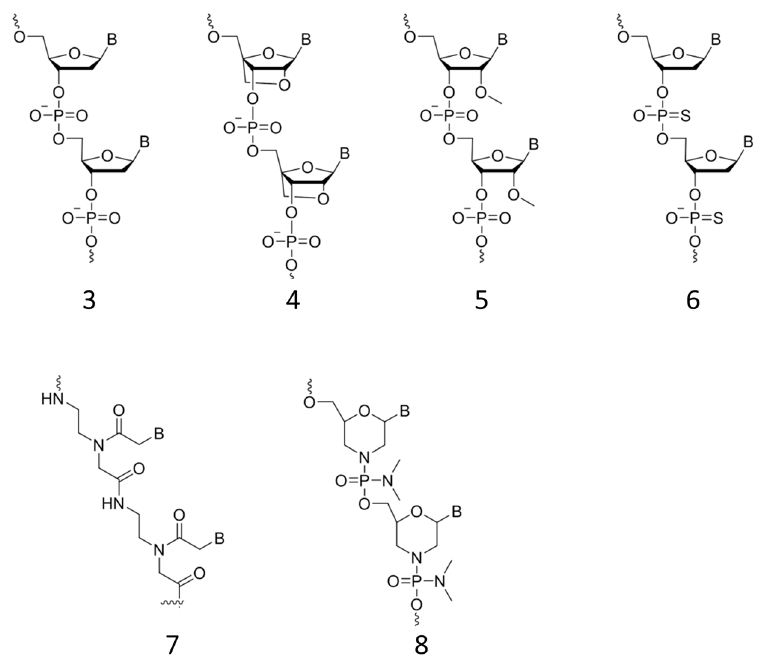
Figure 4. Chemical structures of synthetic oligonucleotides containing modified backbones.